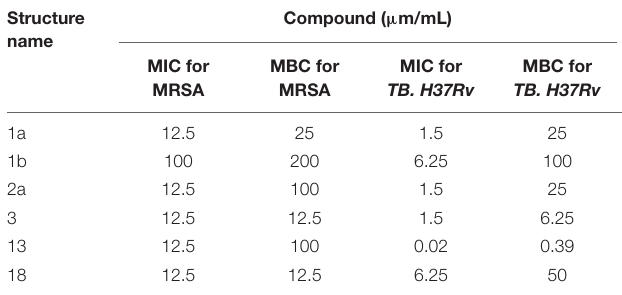
TABLE 6 | Summary of MIC and